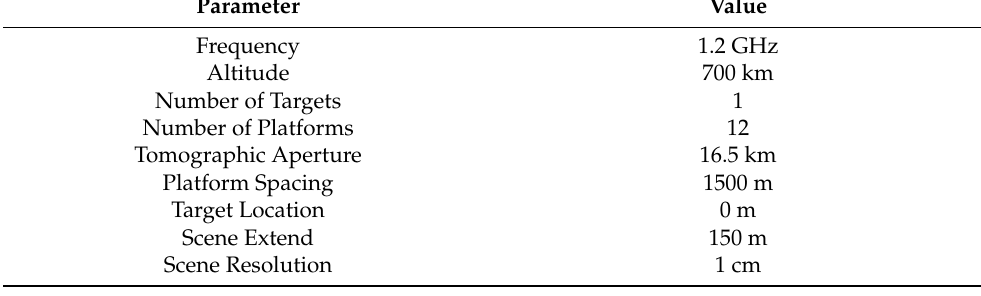
Table 1. Parameters used for the example 1D simulation.